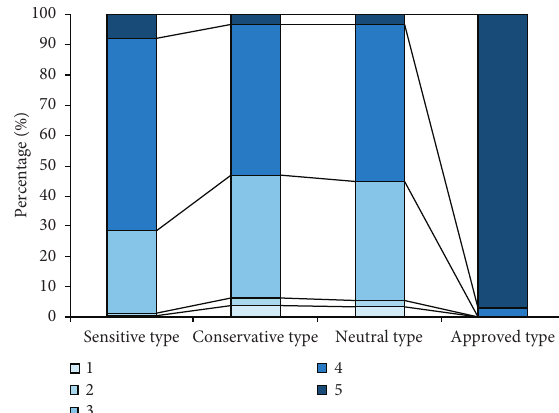
Figure 5: SI of drivers in the four segments.